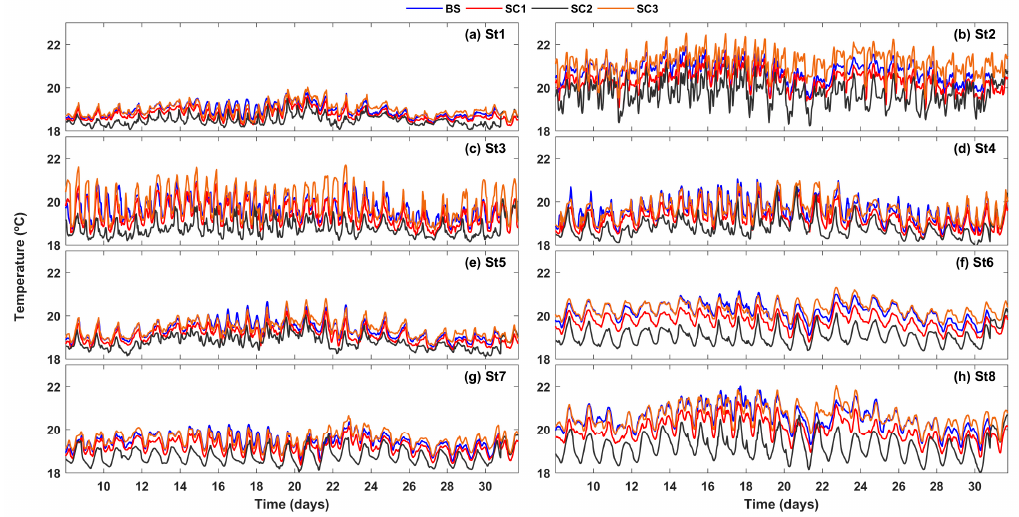
Figure 6. Time series of the water temperature for the scenarios, BS, SC1, SC2, and SC3, for September 2000, and the lagoon stations: ( a ) St1, ( b ) St2, ( c ) St3, ( d ) St4, ( e ) St5, ( f ) St6, ( g ) St7 and ( h ) St8.